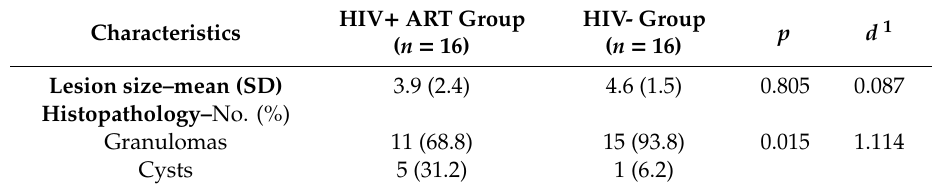
Table 2. Comparison of macroscopic and histopathological characteristics of inflammatory chronic apical periodontitis diagnosed in the two groups studied.